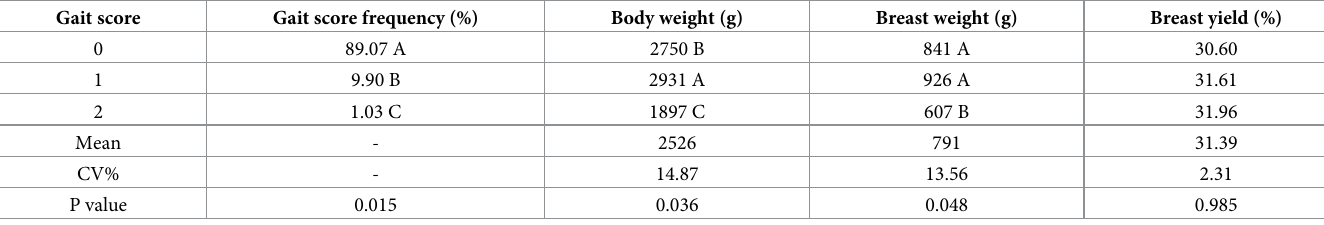
Table 1. Gait score frequency, body weight, and breast weight and yield of broiler chickens at 41 days of age. Gait score Gait score frequency (%)